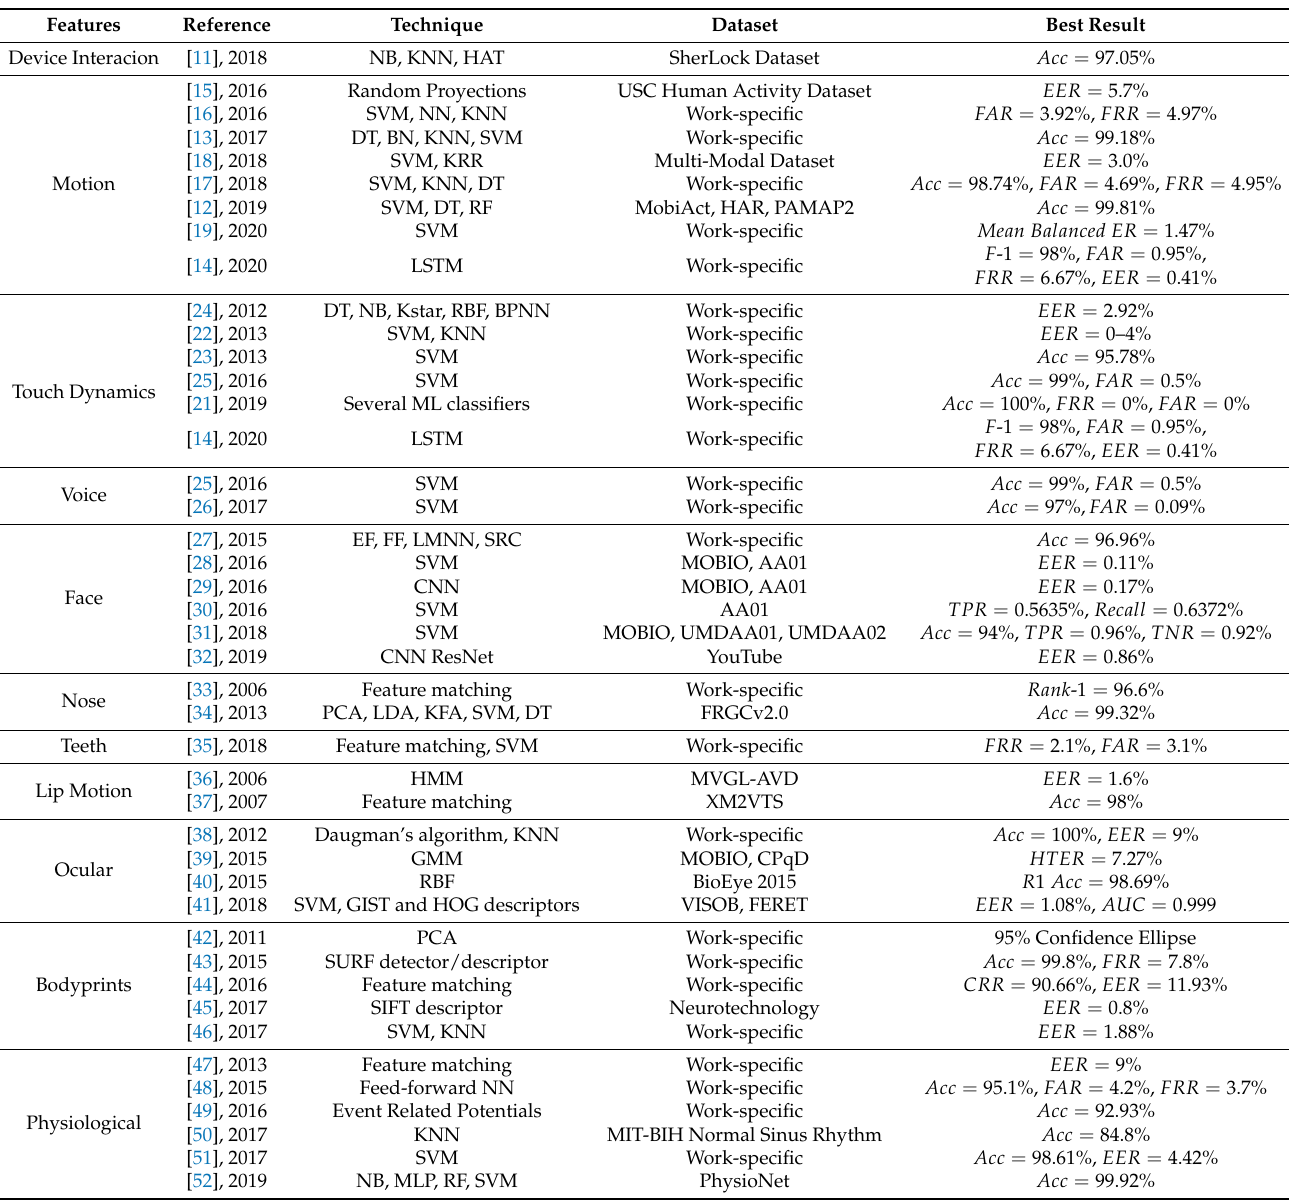
Table 1. Sensor-based Continuous authentication (CA) literature summary (Acc: Accuracy, AUC: Area Under the Curve, BN: Bayesian Networks, BPNN: Back Propagation Neural Network, CNN: Convolutional Neural Networks, CRR: Correct Recognition Rate, DT: Decision Tree, EER: Equal Error Rate, EF: Eigenfaces, ER: Error Rate, FAR: False Acceptance Rate, FF: Fischerfaces, FRR: False Rejection Rate, GMM: Gaussian Mixture Model, HAT: Hoeffding Adaptive Trees, HOG: Histogram of Oriented Gradients, HTER: Half Total Error Rates, HMM: Hidden Markov Model, KFA: Kernel-Fisher’s Analysis, KNN: K-Nearest Neighbor, KRR: Kernel Ridge Regression, LDA: Linear Discriminant Analysis, LMNN: Large Margin Nearest Neighbor, LSTM: Long Short-Term Memory, ML: Machine Learning, MLP: Multi-Layer Perceptrons, NB: Naive Bayes, NN: Neural Network, PCA: Principal Component Analysis, RBF: Radial Basis Function, RF: Random Forest, SIFT: Scale-Invariant Feature Transform, SRC: Sparse Representation Classification, SVM: Support Vector Machine, TNR: True Negative Rate, TPR: True Positive